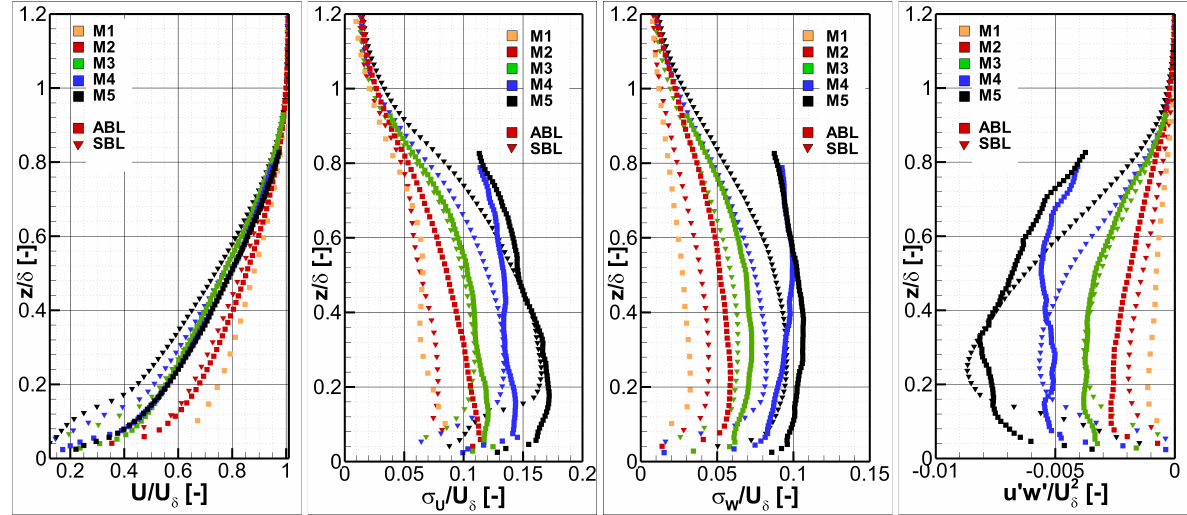
Fig. 2. Mean longitudinal velocity, longitudinal and vertical standard deviation and corresponding momentum flux. Data are taken from the SBLM1-SBLM5 (ABLM1 = SBLM1), with a reference spire distance D4. Each profile is an average along the horizontal coordinate within the investigated region.